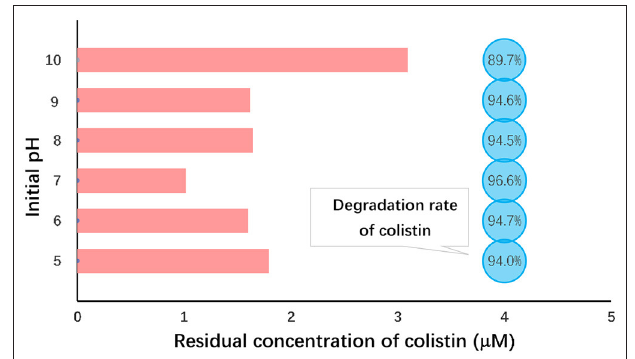
FIGURE 3 | Reaction duration dependence of colistin removal. Initial colistin concentration, 30 µ M; [F (VI)]/(colistin) molar ration, 30; initial pH, 7.0; temperature, 25 ◦ C, reaction duration,